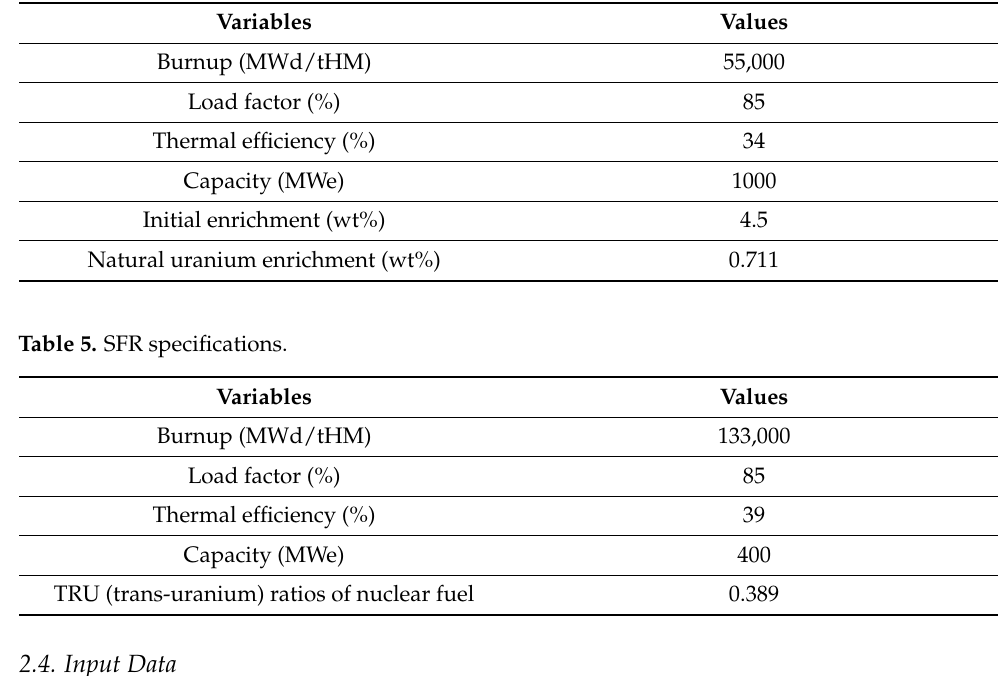
Figure 3. Material flow of pyro-SFR fuel cycle. Here, HLW = high-level radioactive waste, SFR SF = sodium-cooled fast reactor spent nuclear fuel, TRU = trans-uranium.